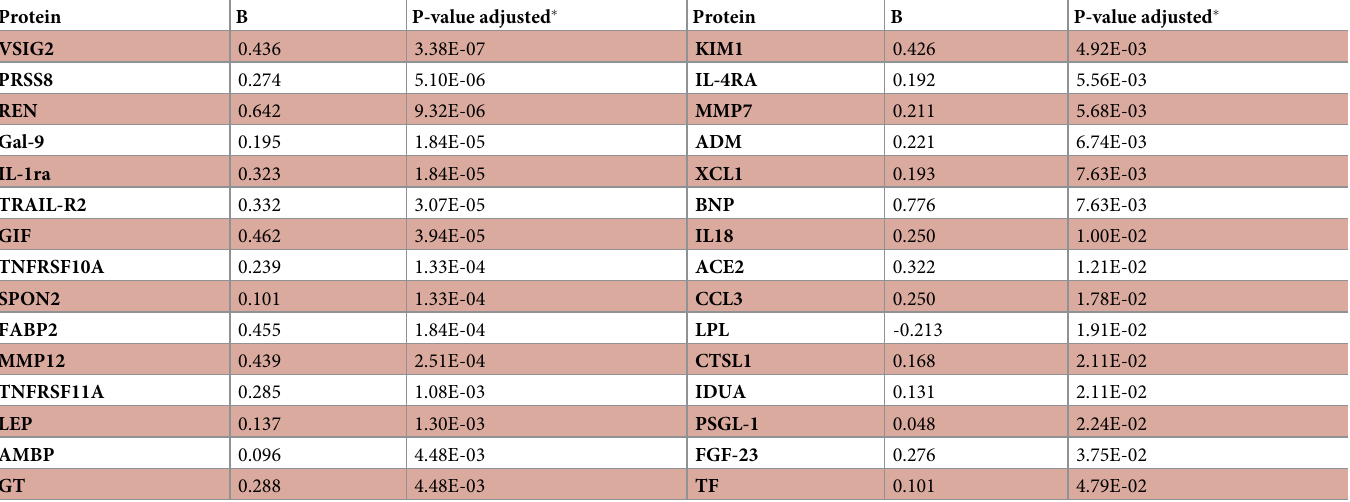
Table 3. Proteins significantly altered in subjects with CAD compared with subjects without